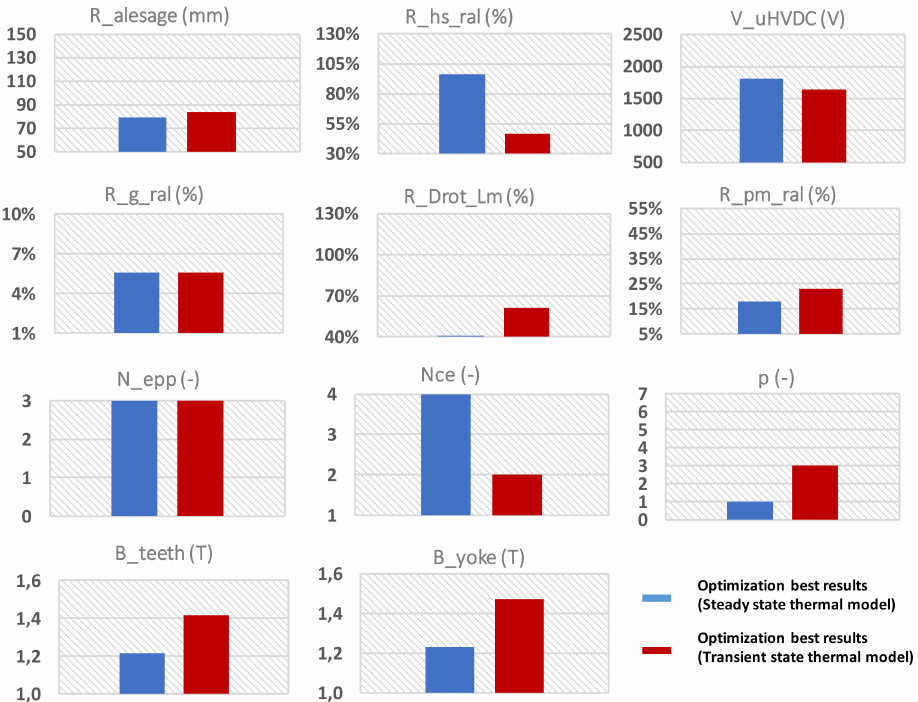
Figure 18. Decision variables giving the best objective function for both optimizations.